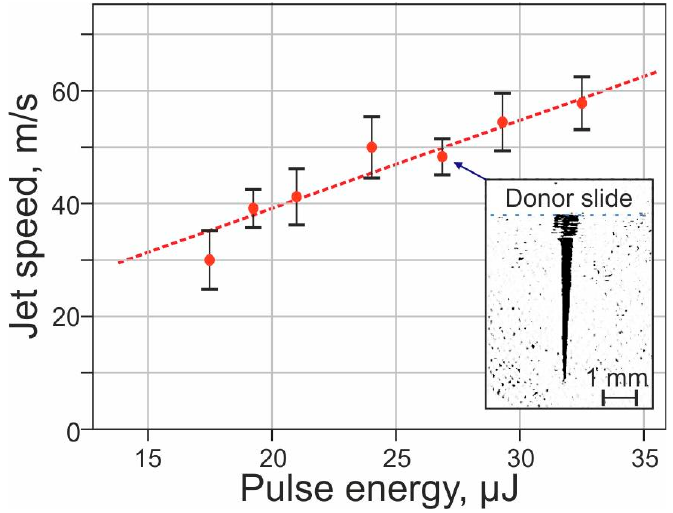
Figure 2. Dependence of gel jet velocity on laser pulse energy. The inset shows an example frame from a high-speed video of a gel jet formed 100 μ s after laser pulse absorption.